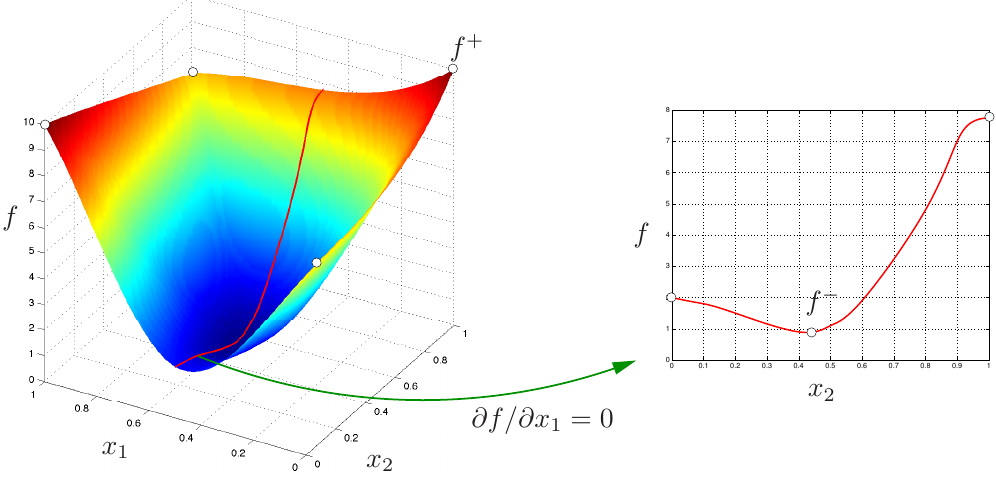
Figure 4. Schematic illustration of how to determine the exact bounds of f ( x 1 , x 2 ) analyzing its monotonicity. We have to consider the value of the function in selected corners of the domain and the sub-spaces where ∂ f / ∂ x 1 = 0 or where ∂ f / ∂ x 2 = 0, if such conditions may hold in the domain. These sub-spaces have to be recursively analyzed. For instance, the plot at the right shows this analysis = 0 and x + = 1 gives f + , the upper bound of this function for the first case. The evaluation of f on x − 2 1 in the prescribed domain. In this example, the lower bound f − is obtained in the analysis of the sub-space where ∂ f / ∂ x 1 = 0. Figure adapted from [15].